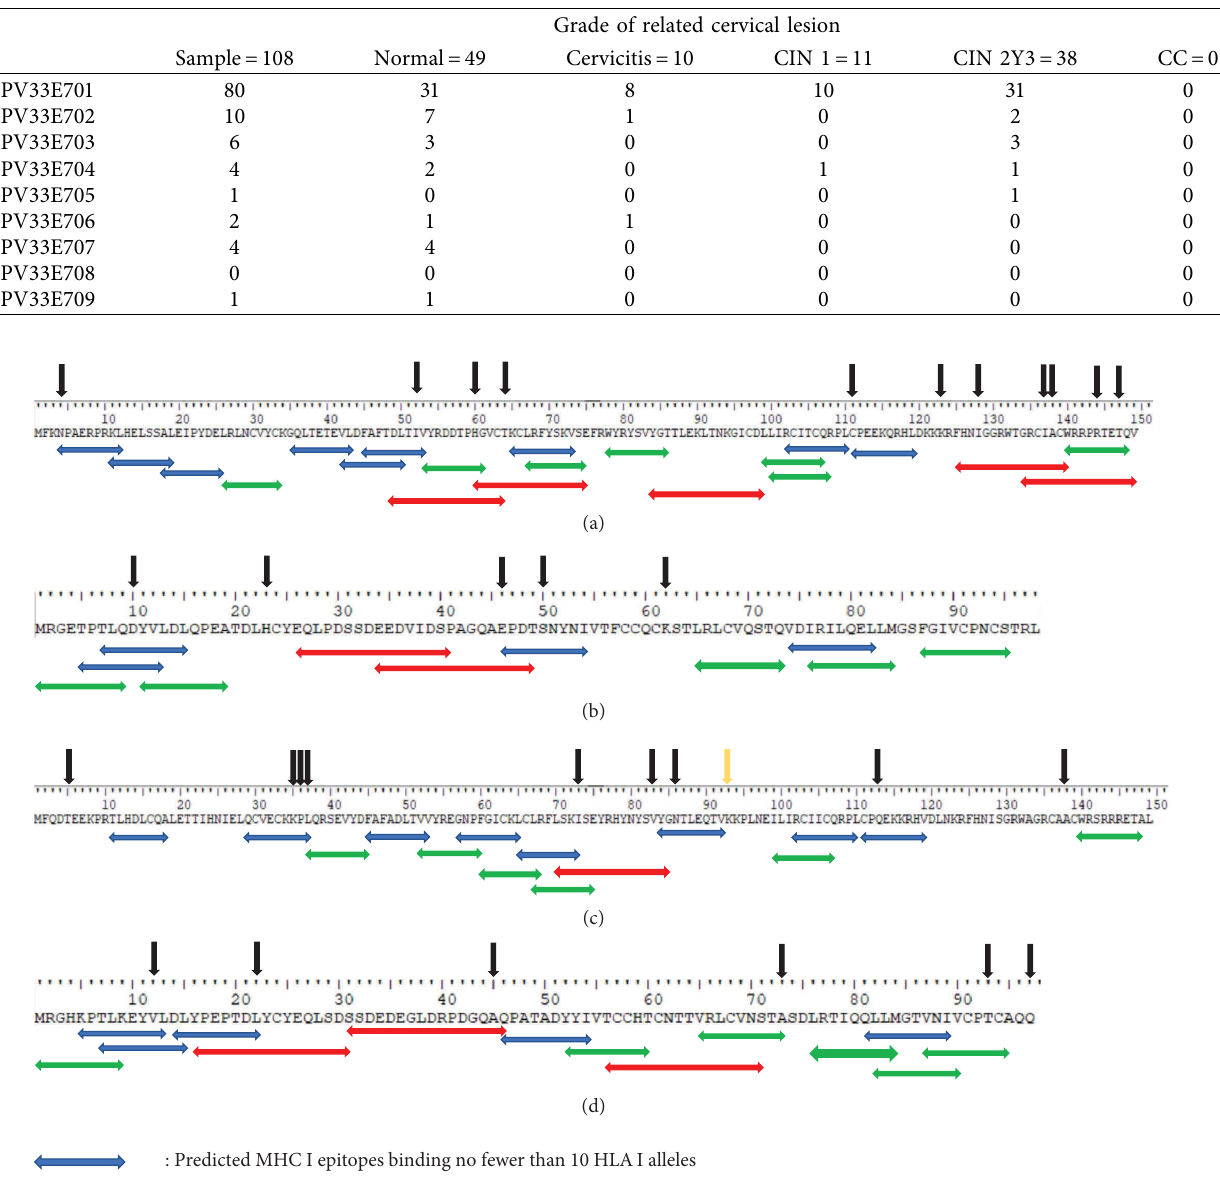
Table 9: Te associations of HPV33E7 variants with cervical disease.